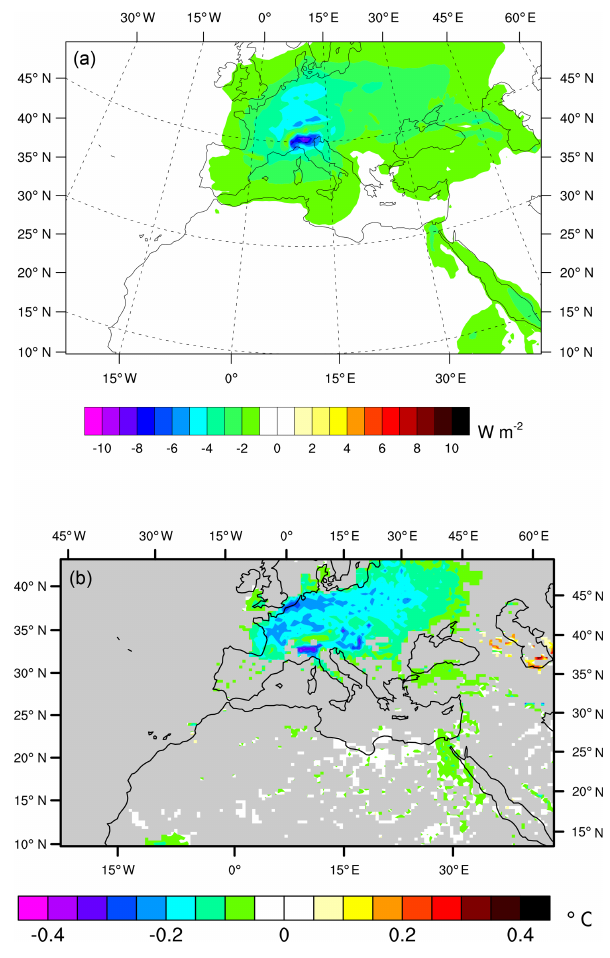
Figure 15. DRF SW (Wm − 2 , a ) at the surface in all sky conditions and the A&N aerosols impact on the near-surface air temperature at 2m ( ◦ C, b ) on average over the period 1979–2016 in summer (JJA) obtained by difference between the REF and NIT simulations. For the temperature map, the grey area is not statistically significant at the 0.05